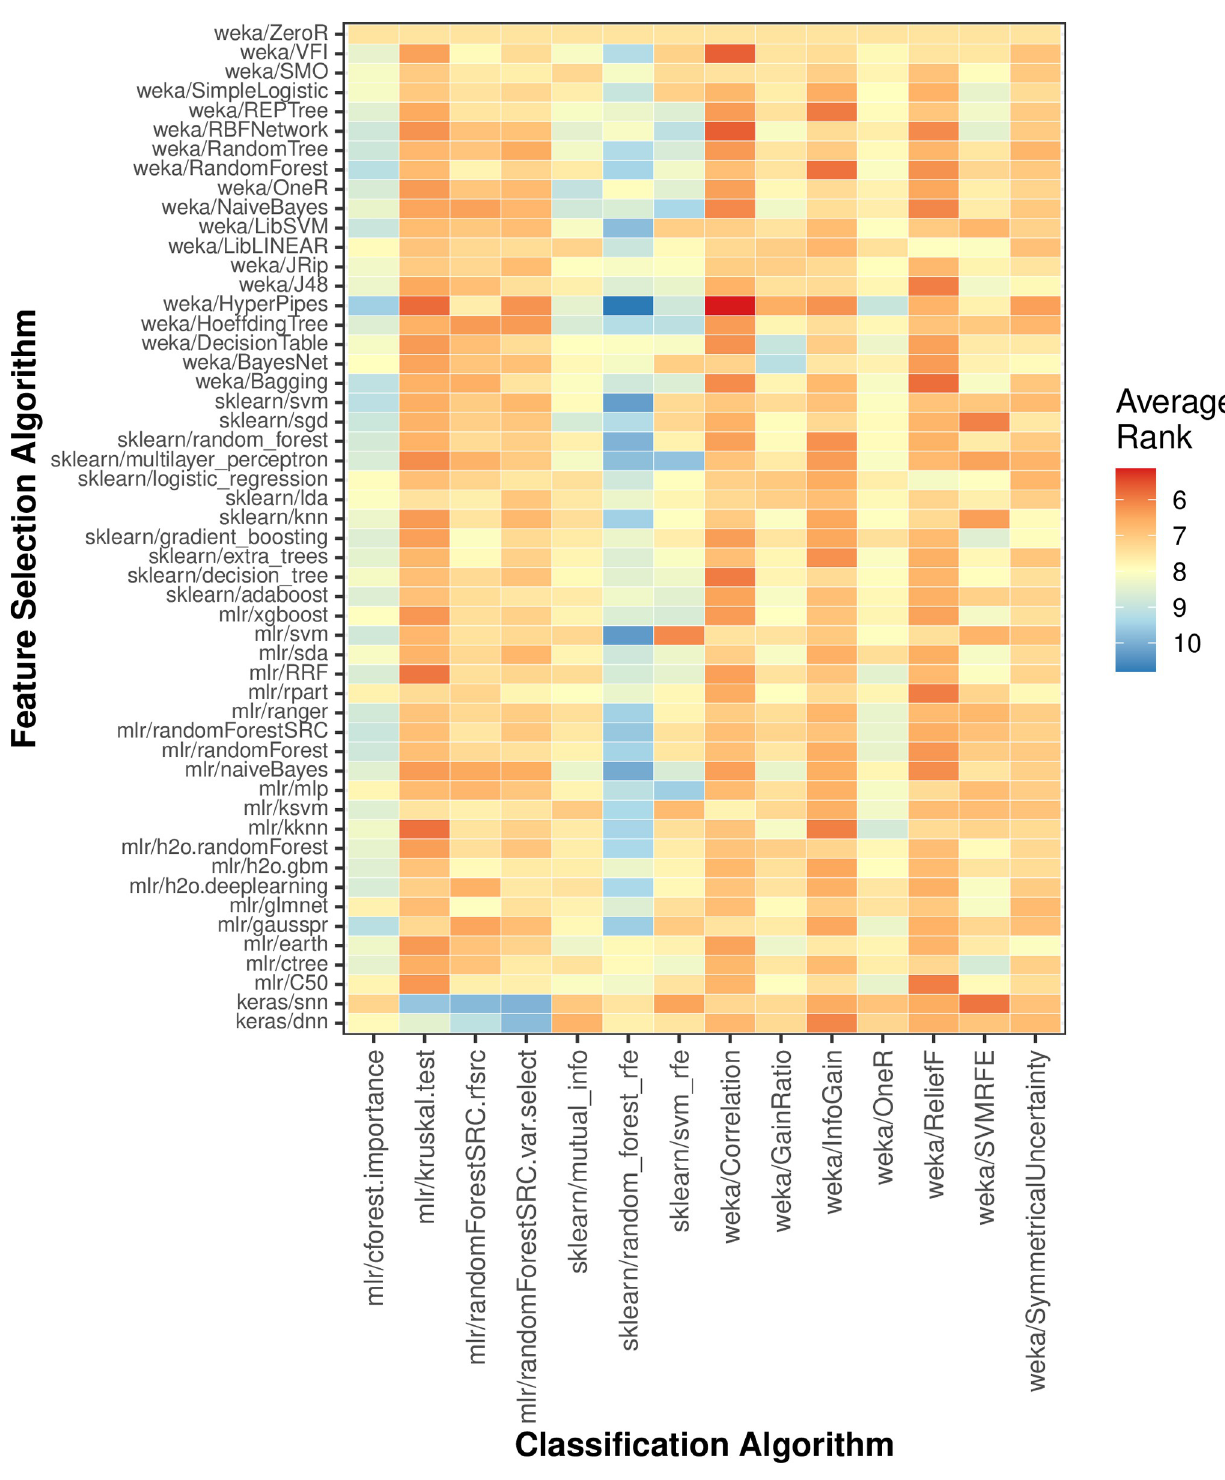
Fig 7. Relative classification performance per combination of feature-selection and classification algorithm. For each combination of dataset and class variable, we averaged area under receiver operating characteristic curve (AUROC) values across all Monte Carlo cross-validation iterations. Then for each classification algorithm, we ranked the feature-selection algorithms based on AUROC scores across all datasets and class variables. Lower ranks indicate better performance. Dark-red boxes indicate cases where a particular feature-selection algorithm was especially effective for a particular classification algorithm. The opposite was true for dark-blue